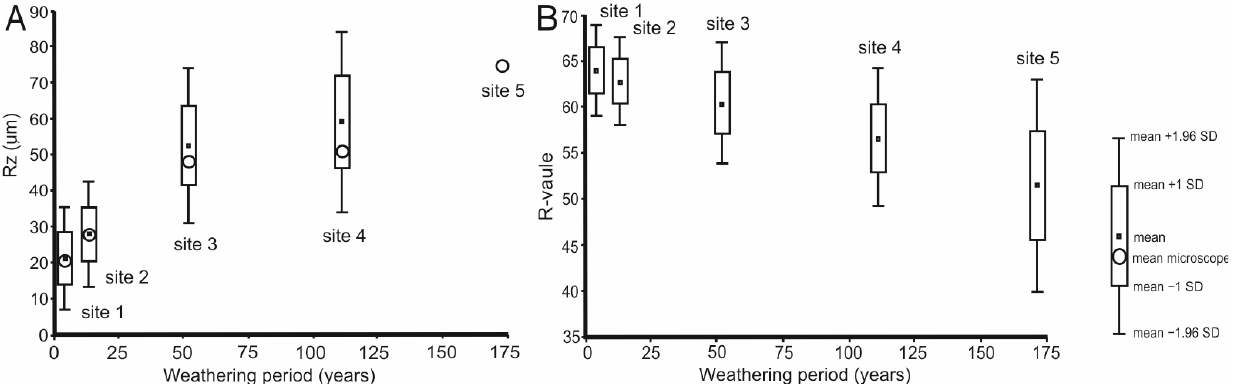
Figure 3. Rock surface micro-roughness ( A ) and strength ( B ) changes in the Hallstätter Glacier foreland. Box-and-whisker diagrams shows results obtained from the Handysurf and circles show additional results from the KDM ( A ).